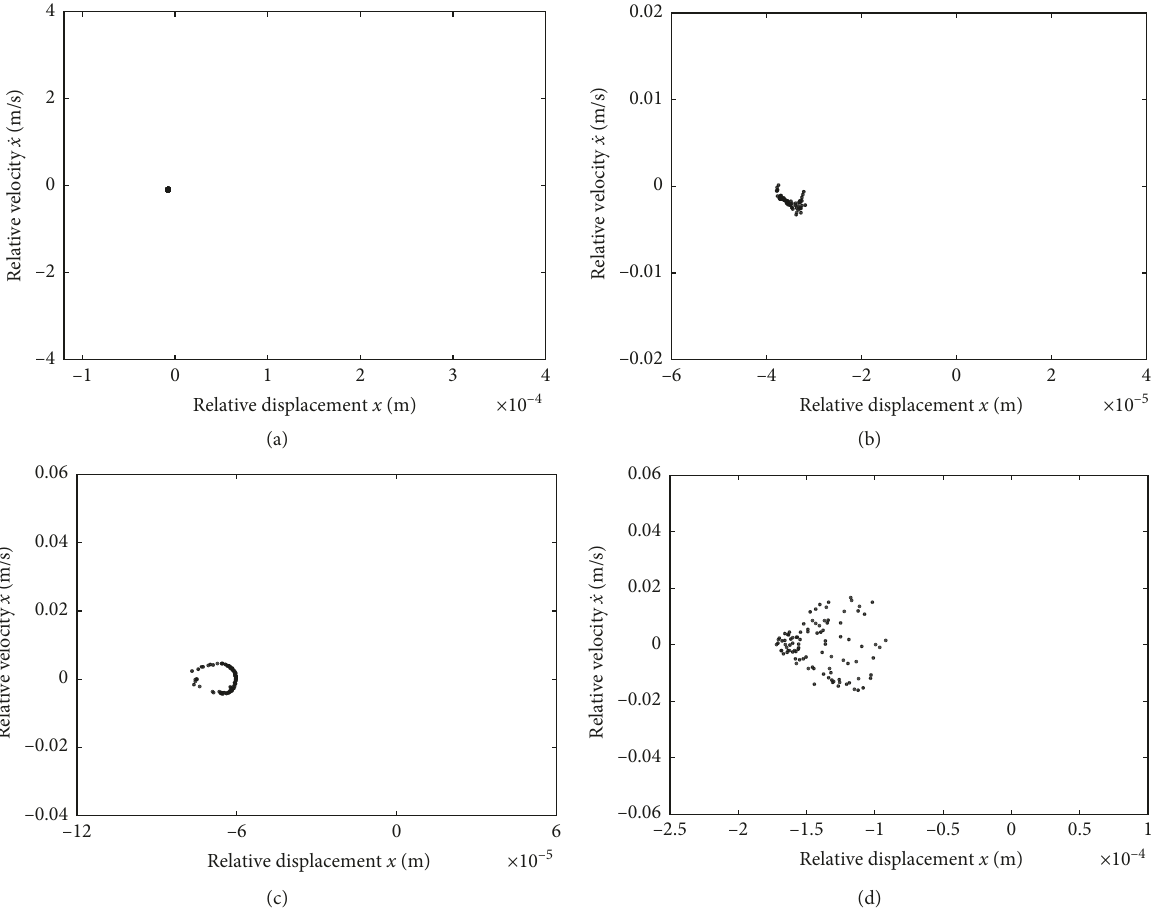
Figure 11: Poincar´e portrait of 2-DOF nine-bar mechanism for different clearance values: (a) clearance � 0.01 mm; (b) clearance � 0.05mm; (c) clearance � 0.1mm; (d) clearance �